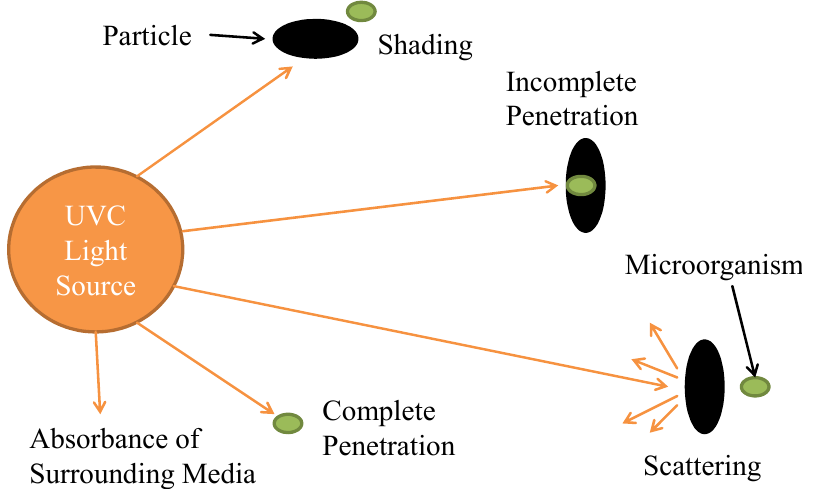
Figure 9. Particle interactions with UVC radiation inside a